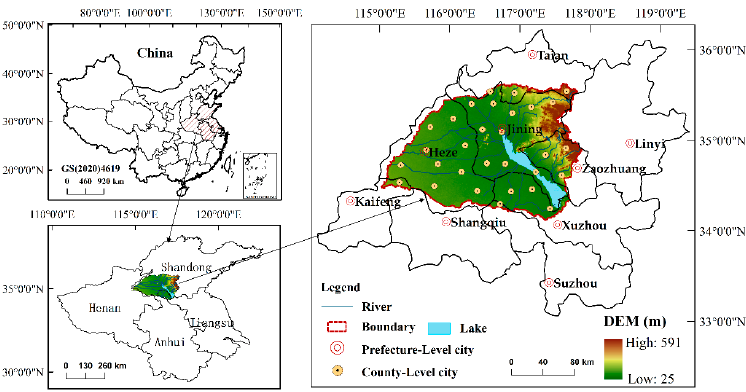
Figure 1. Location of study area.